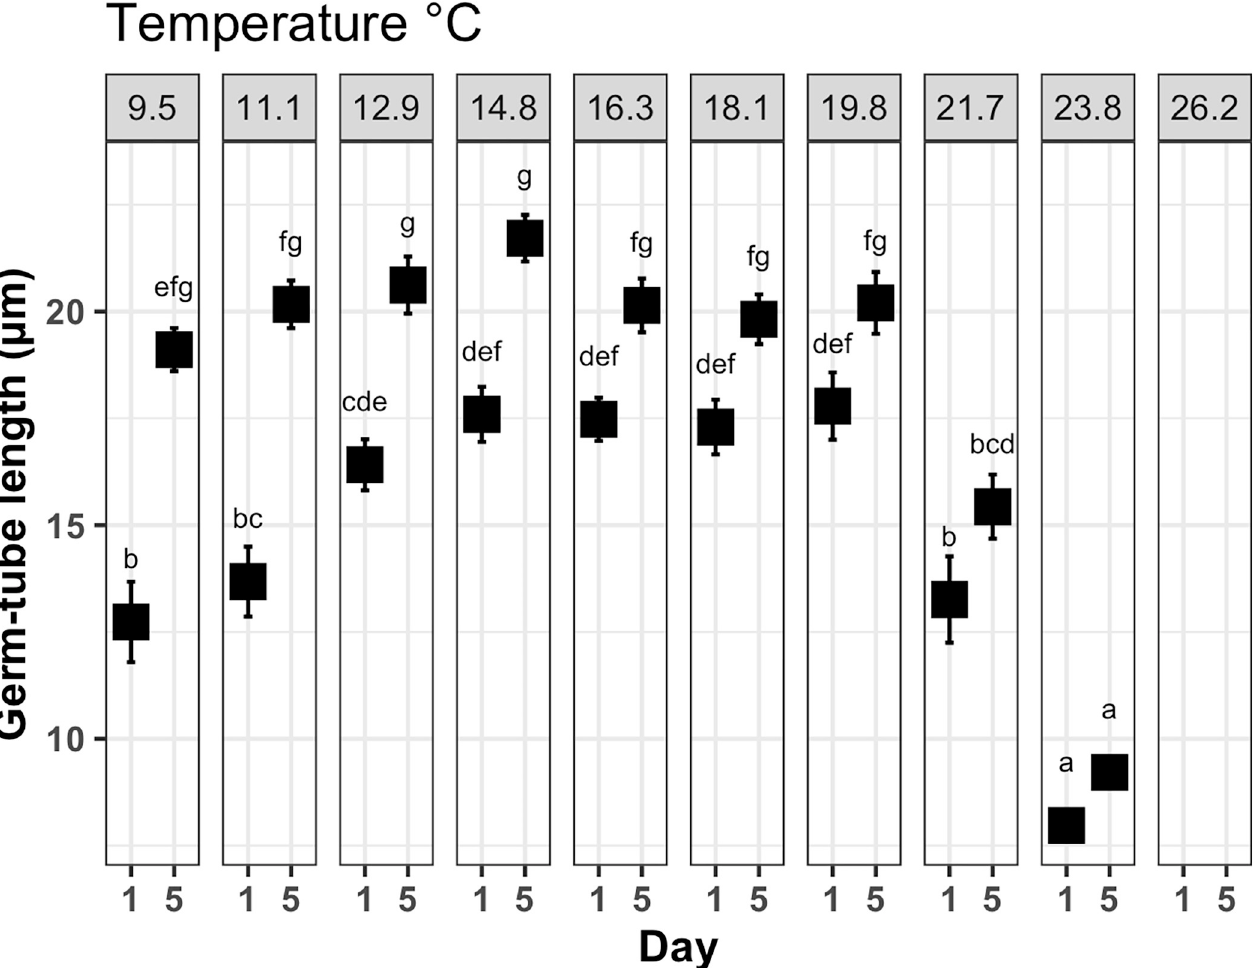
Fig 2. Mean ( ± SE) length of germ-tube ( μ m) of germinated spores of M . pyrifera in each of two sampling points with ten different temperature treatments from 9.5–26.2 ± 0.2˚C. Letters indicate statistical significance between treatments and time (Tukey-adjusted, p-value < 0.05), n = 6, (except treatment 12.9˚C: n =